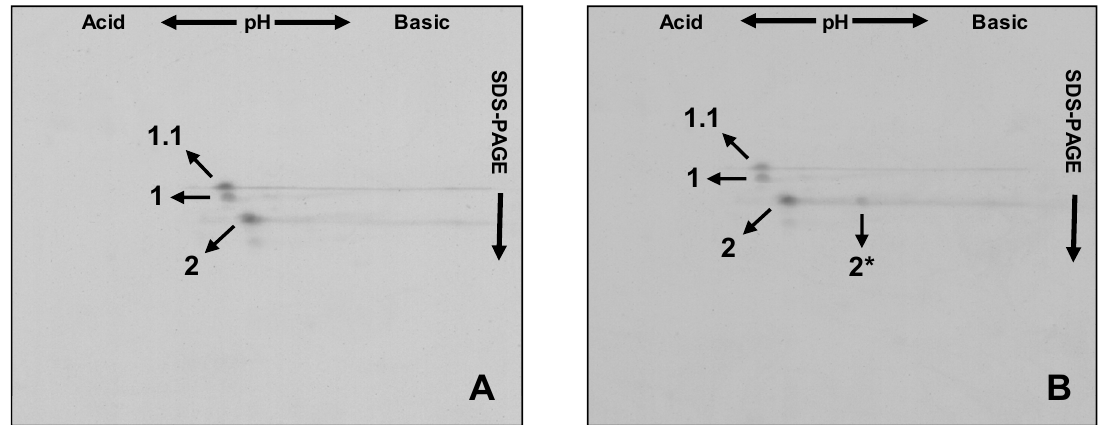
Figure 3. Overlap of two-dimensional patterns of HMW-GS from ‘Barbela 28’ wheat line and other extracts ( A ) with the variety ‘Carala’ and ( B ) with an equal mixture from varieties ‘Carala’ and ‘Atlas 66’. Subunits 1.1, 1, 2 and 2* are